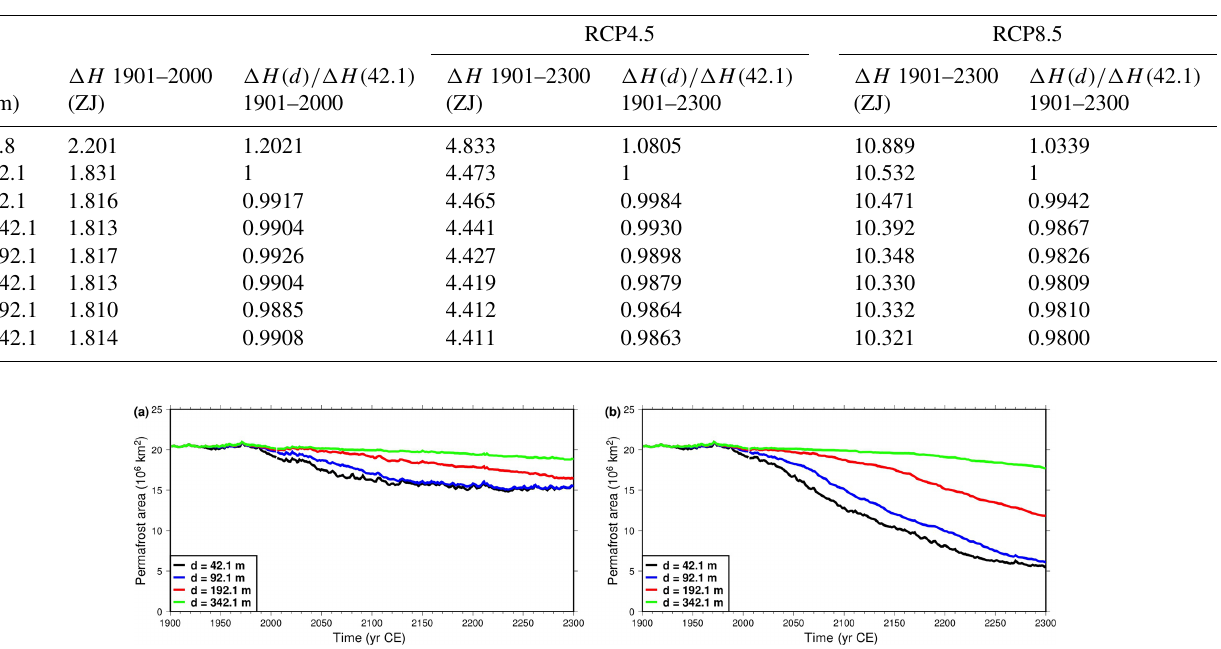
Table 2. Heat stored in the soil (upper 3 . 8m) since 1901CE for the years 2000 and 2300CE for the RCP4.5 and RCP8.5 scenarios, as function of subsurface thickness d .